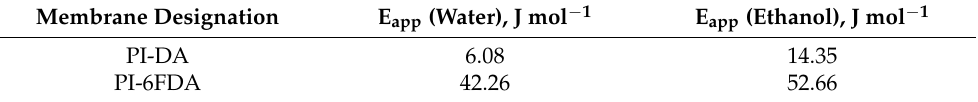
Table 6. The apparent activation energy of water and isopropanol of PI-DA and PI-6FDA membranes.